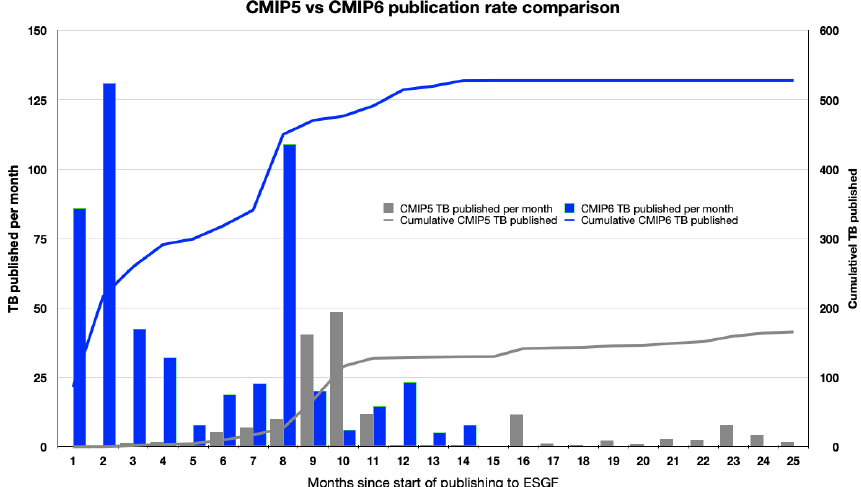
Figure 8. The cumulative and per-month increases in the volume of data published to ESGF. During CMIP5, the ESGF software was stressed and problems arose. Despite those problems, NCAR was able to publish 165TB of data. In preparation for CMIP6, the problems with the ESGF software stack were addressed and through these improvements, NCAR was able to publish 528TB of data within 14 months, an increase in volume by 3 times. In the first 2 months of the CMIP6 publication process, NCAR smoothly published over 216TB of data, over 50TB more than it contributed towards